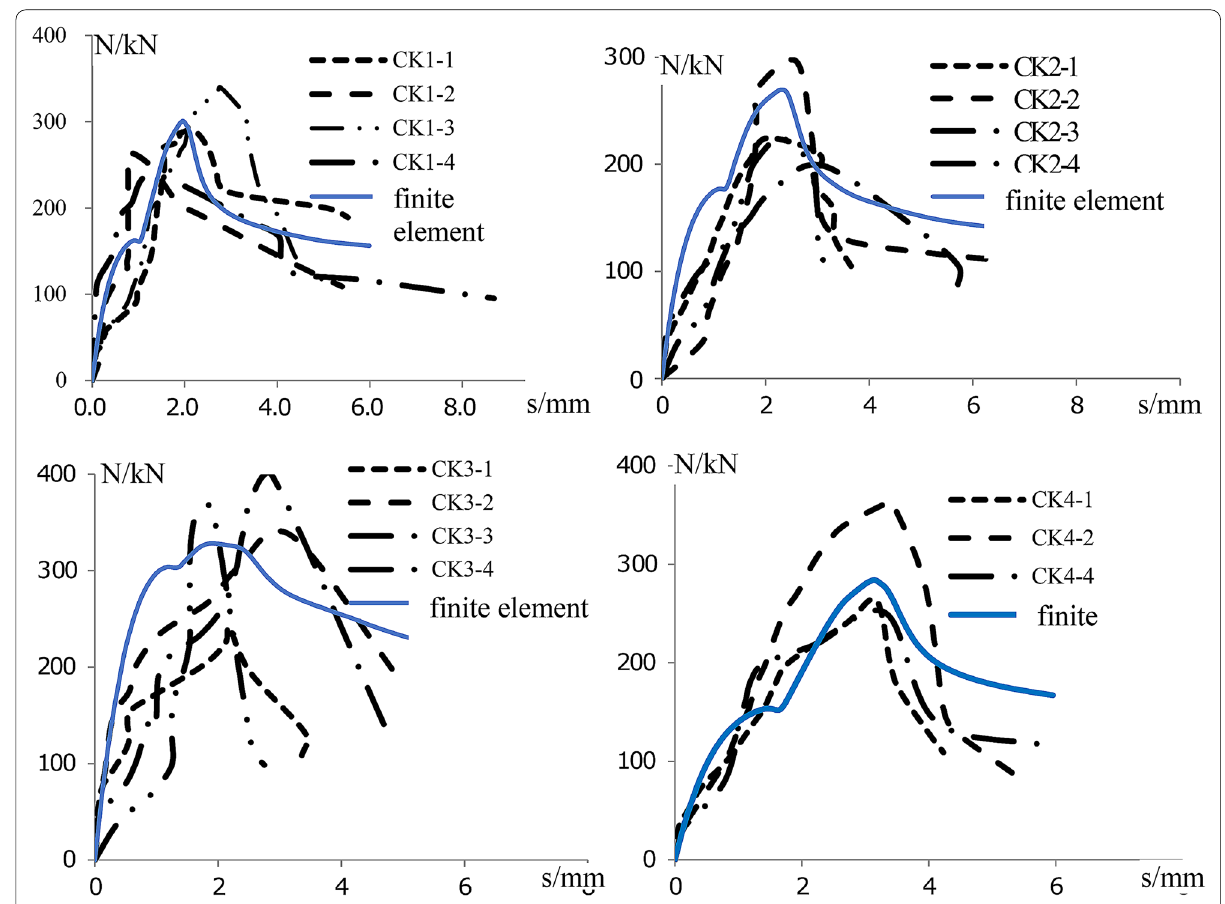
Fig. 13 Analytical and experimental load–displacement curves.